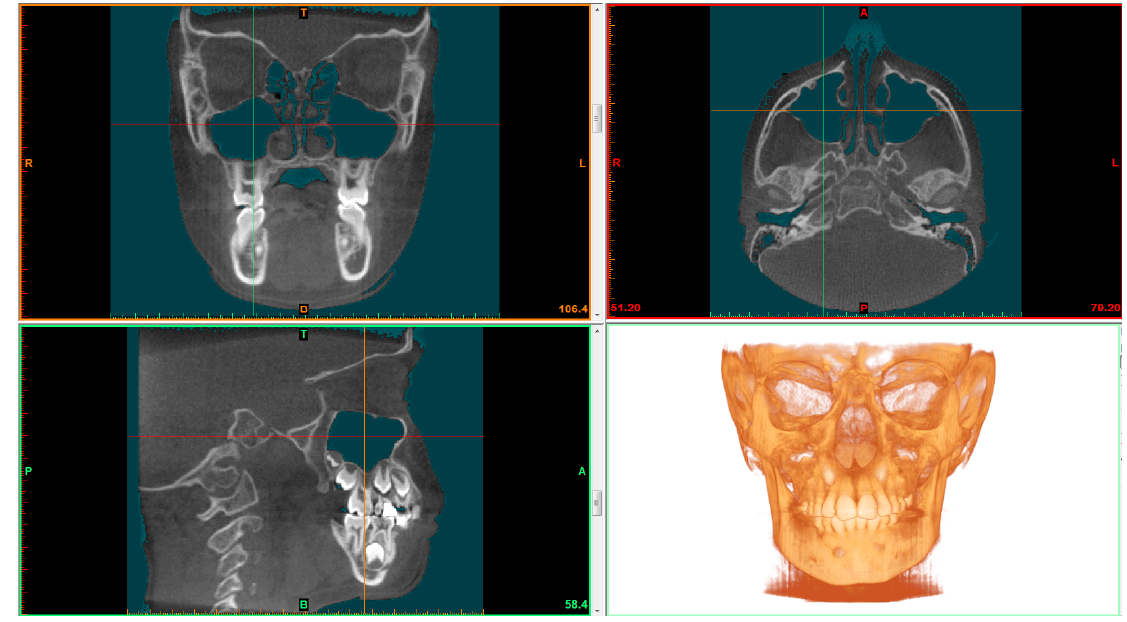
Figure 1. Sagittal, coronal and axial view after thresholding.